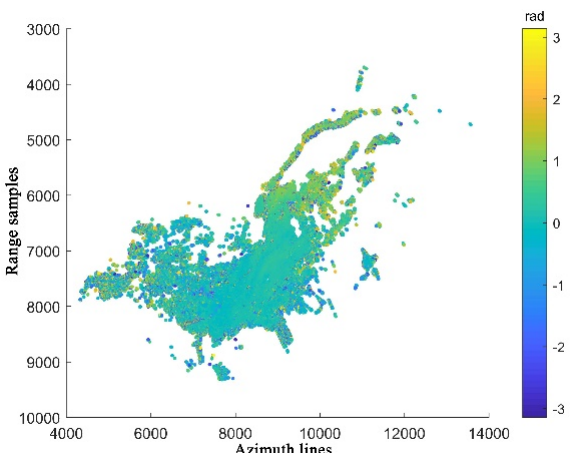
Figure 17. Residual phase map after filtering. The residual phase is filtered by the spatial domain filtering algorithm, and the filtered phase is obtained.